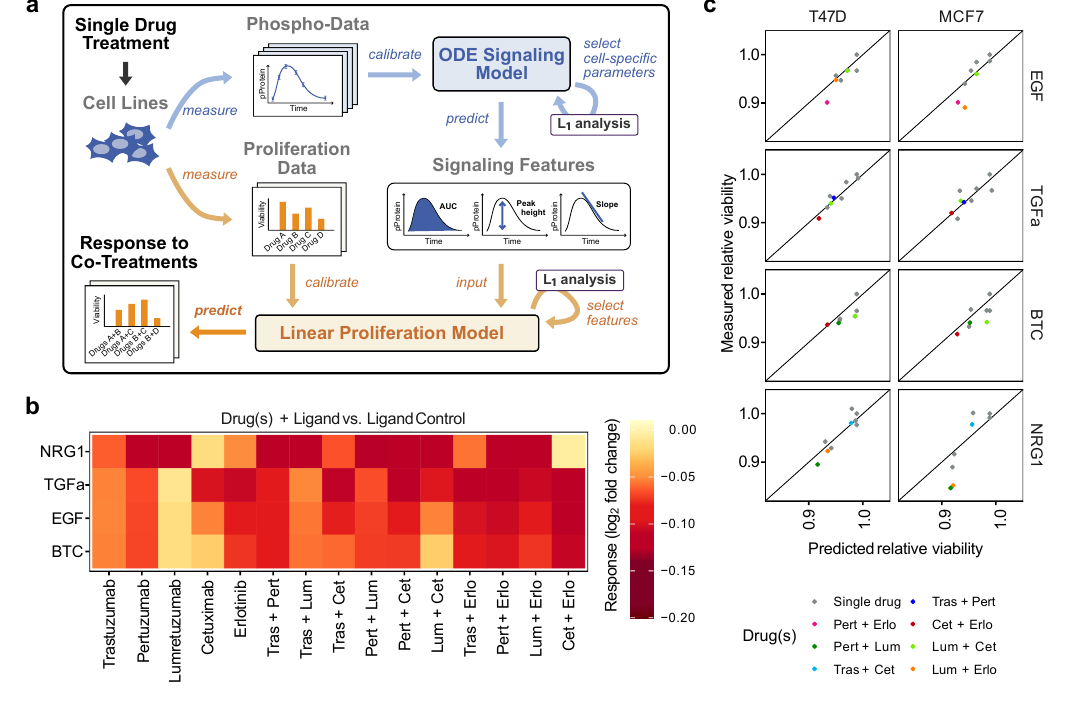
Figure 4. Model-based proliferation predictions. ( a ) Schematic overview of the proliferation predic- tion process. Signaling features were simulated based on the calibrated ODE model and used as input for the linear proliferation model to predict condition-specific proliferation responses. Single treatments were used for model calibration to predict the response to co-treatments. ( b ) Proliferation predictions of MCF7 cells pre-treated with a single or a combination of drugs, followed by a stimu- lation with the indicated ligand. Data are displayed as log2 fold change relative to the ligand-only control. ( c ) Cell viability data were experimentally collected and used to assess the predictive power of the model for co-treatment predictions. Single treatments used for model calibration are shown in grey, while validation co-treatments are colored. Drugs are abbreviated for co-treatment denotation: Cet—cetuximab, Erlo—erlotinib, Tras—trastuzumab, Pert—pertuzumab and Lum—lumretuzumab. Data points are displayed as the fold change relative to the ligand